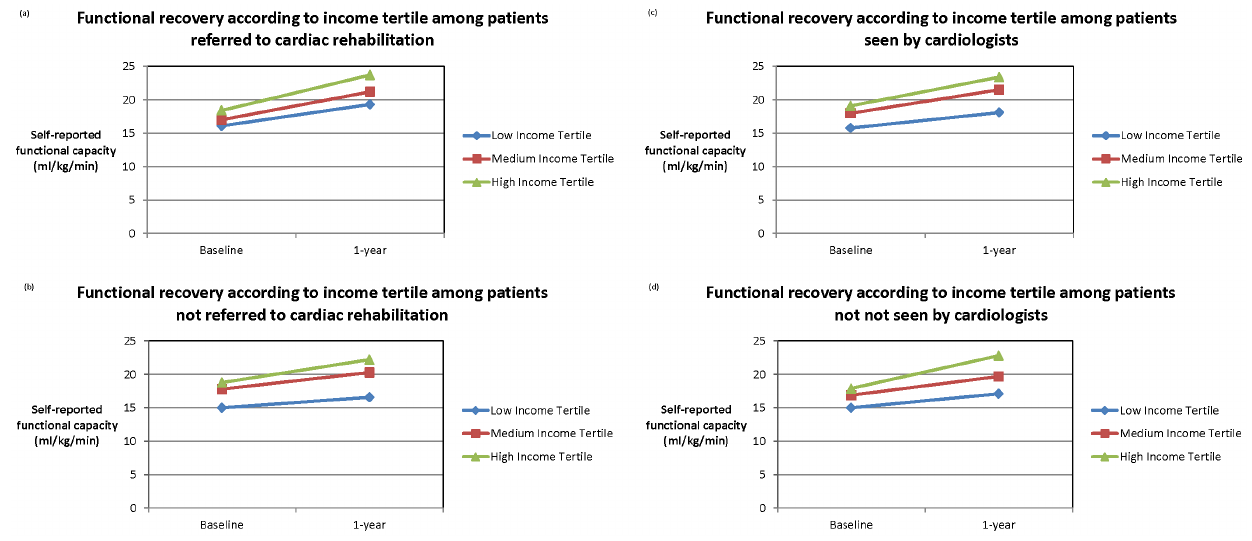
Figure 1. Function recovery according to income tertile among patients referred to cardiac rehabilitation (Figure 1a), not referred to cardiac rehabilitation (Figure 1b), seen by a cardiologist in follow-up (Figure 1), not seen by a cardiologist in follow-up (Figure 1d). doi:10.1371/journal.pone.0065130.g001 PLOS ONE |